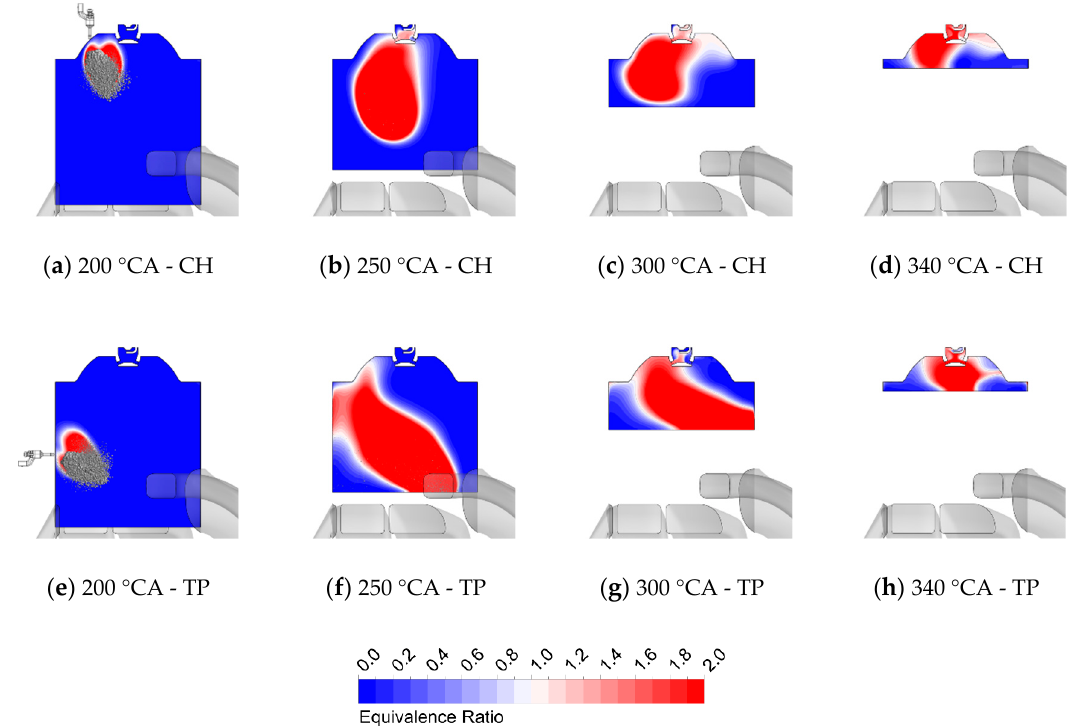
Figure 16. Spray behavior and equivalence ratio contours at 7500 rpm and 30% of load with PN6 prechamber for both injection strategies.